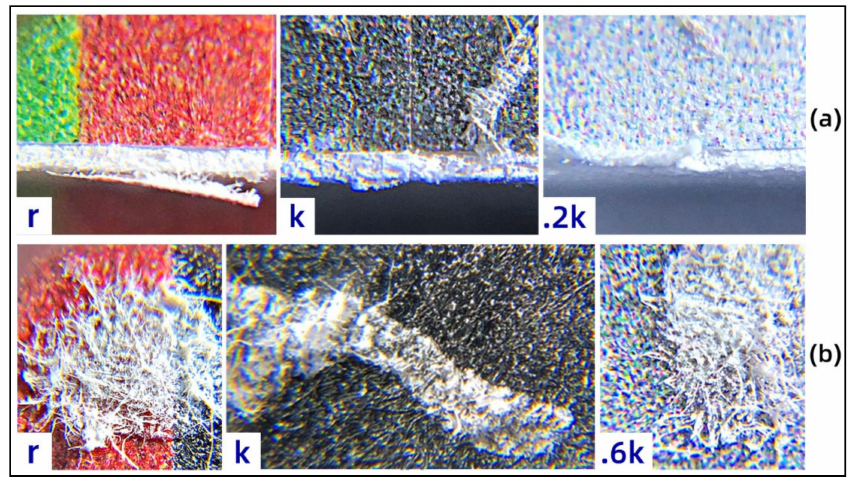
Figure 6. Surface microscopic defects of paper-based full-color 3D prints: ( a ) microscopic whitening defects; ( b ) microscopic fiber adhesion defects.